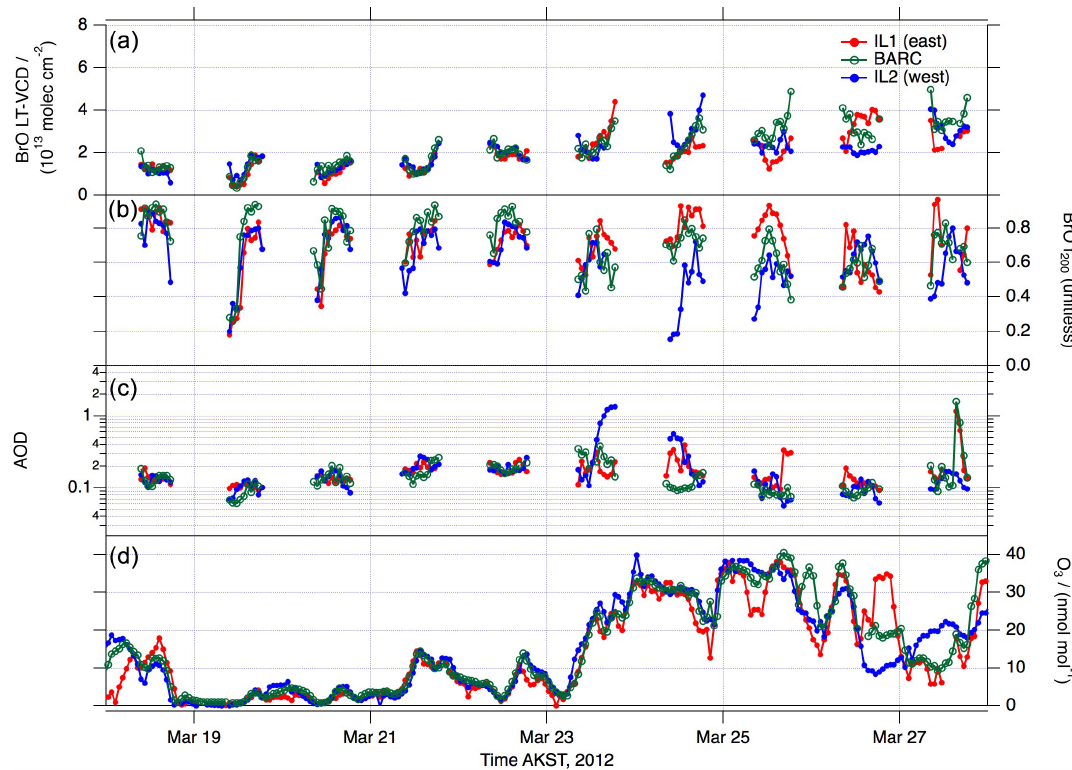
Figure 5. The same as in Fig. 4 but for period B2. IL2 began drifting away from BARC on 23 March.